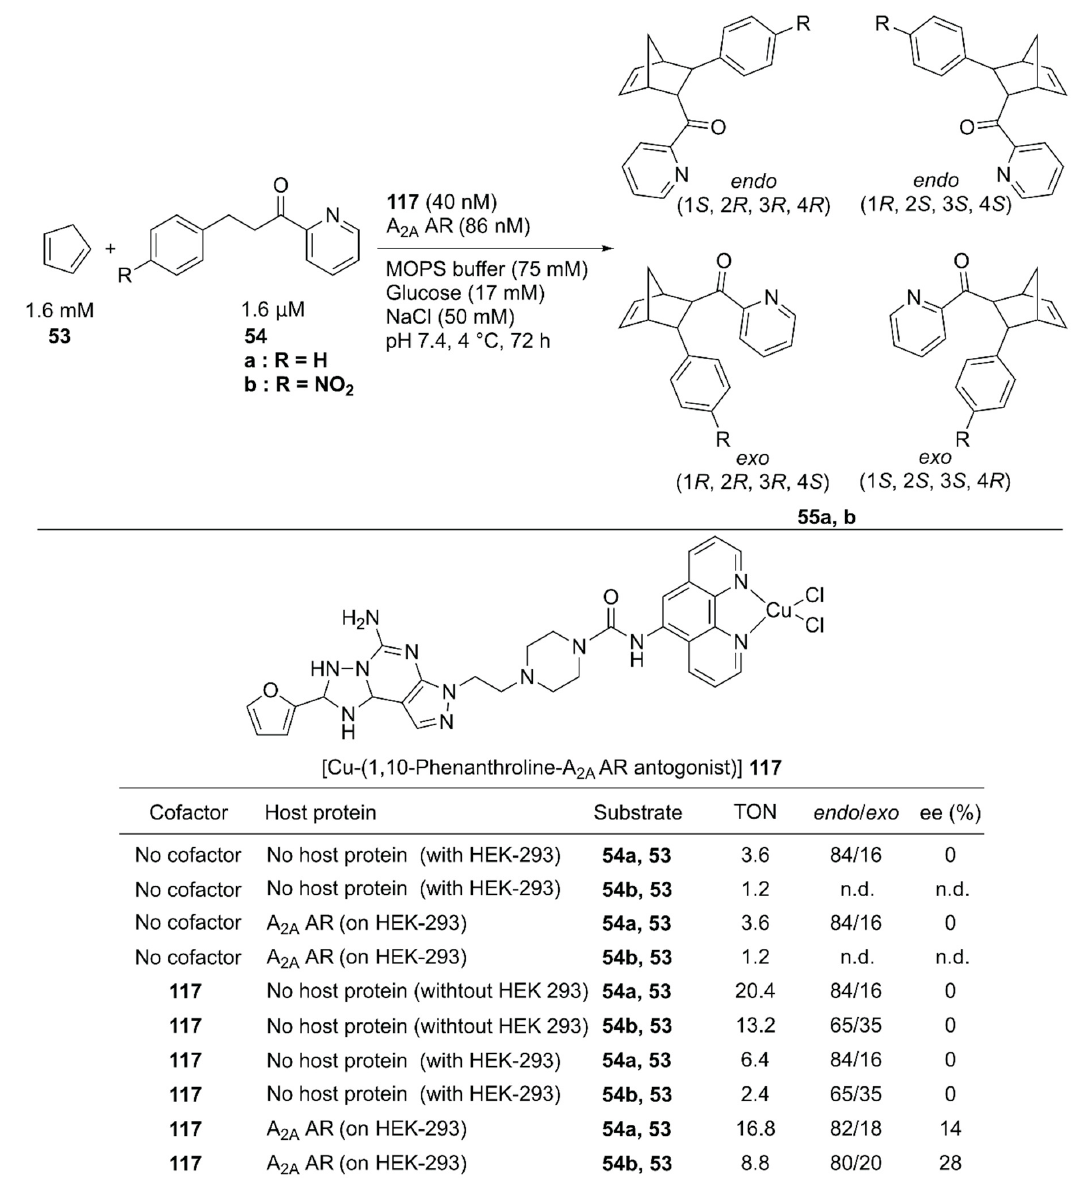
· A 2A . Adapted from